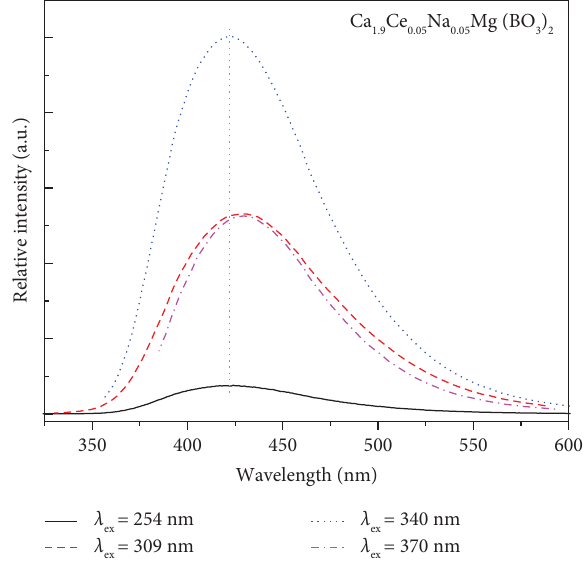
Figure 4: Te emission spectra of Ca under diferent excitation wavelengths at